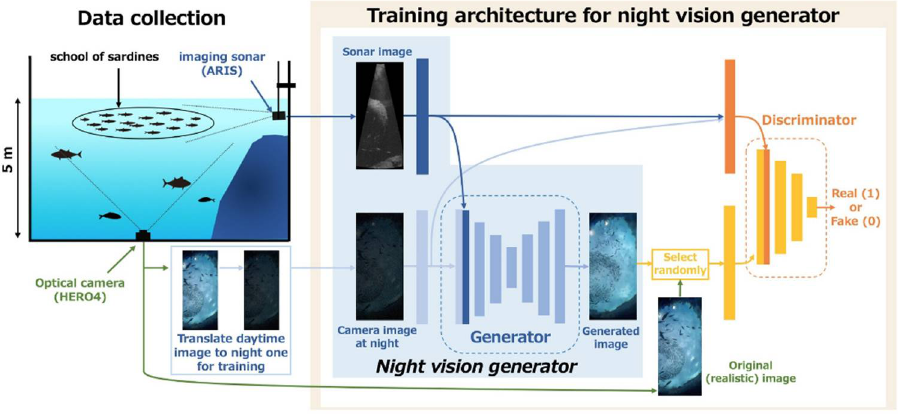
Figure 9. GAN architecture used in [92].